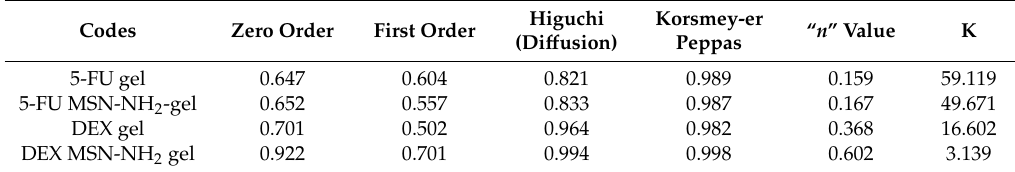
Figure 8. Release profiles of 5-FU and DEX in PBS (pH 7.8) from MSN-NH 2, free in gel, and control ( A ). Relaxational to diffusional ratio as a function of time for DEX and 5-FU from MSN-NH2 at pH of 7.4 ( B ). The Fickian release fraction of DEX/5-FU MSN-NH 2 gel ( C ). Permeability of 5-FU and DEX in MSN-NH 2 and free in gel ( D ). Data are represented as mean ± SD ( n = 3). Table 2. Release kinetics of free formulations, 5-FU MSN-NH 2 , and DEX MSN-NH 2 loaded using different release kinetic models.